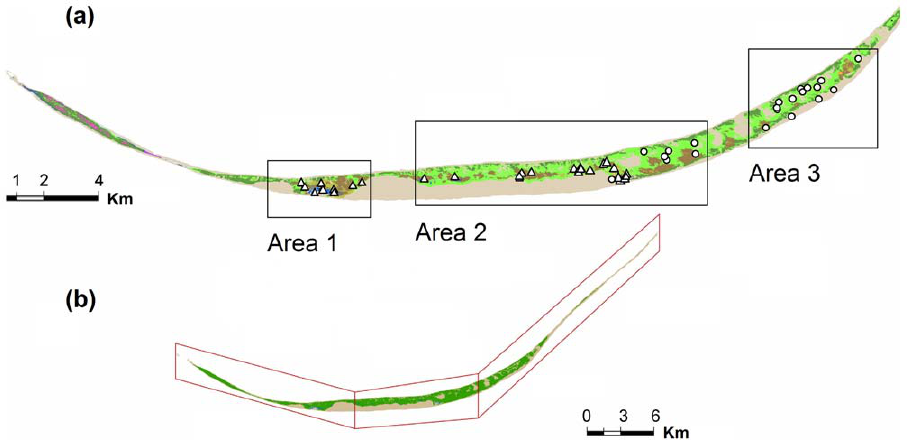
Figure 1. Study area and longitudinal gradient in sources of fresh water for feral horses on Sable Island, Canada, 2008–2010. (a) Sources of water ( n =122) grouped according to hierarchical cluster analysis, with area 1 containing only permanent ponds (triangles); area 2 containing permanent ponds and horse-excavated wells (circles); and area 3 containing only excavated wells. (b) Boundaries for areas 1, 2, and 3 that include clusters of water sources and the exclusive movements of females using those water